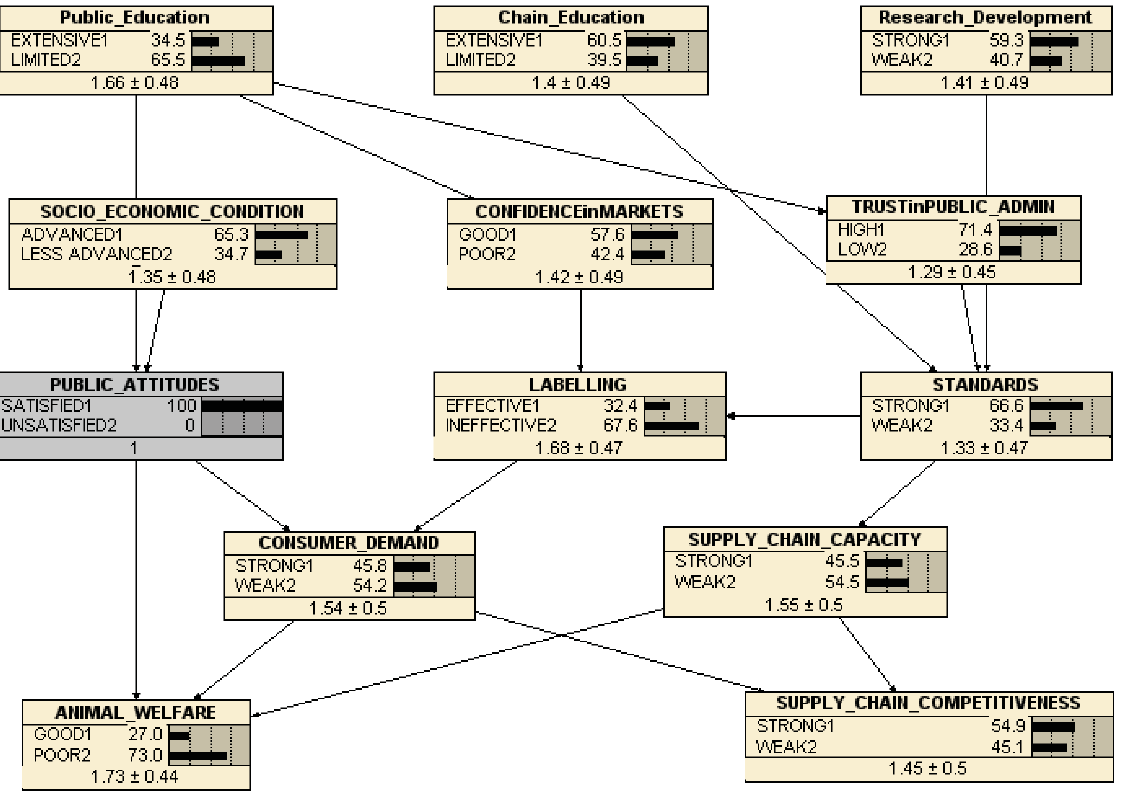
Figure 8. Belief network consequences of improving public